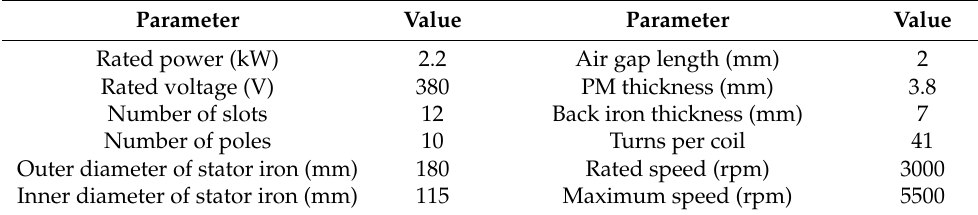
Figure 16. Axial-flux ISG and LPMSM. ( a ) Axial-flux ISG, ( b ) LPMSM at middle diameter. Table 2. Main parameters of axial-flux ISG with DTP-FL